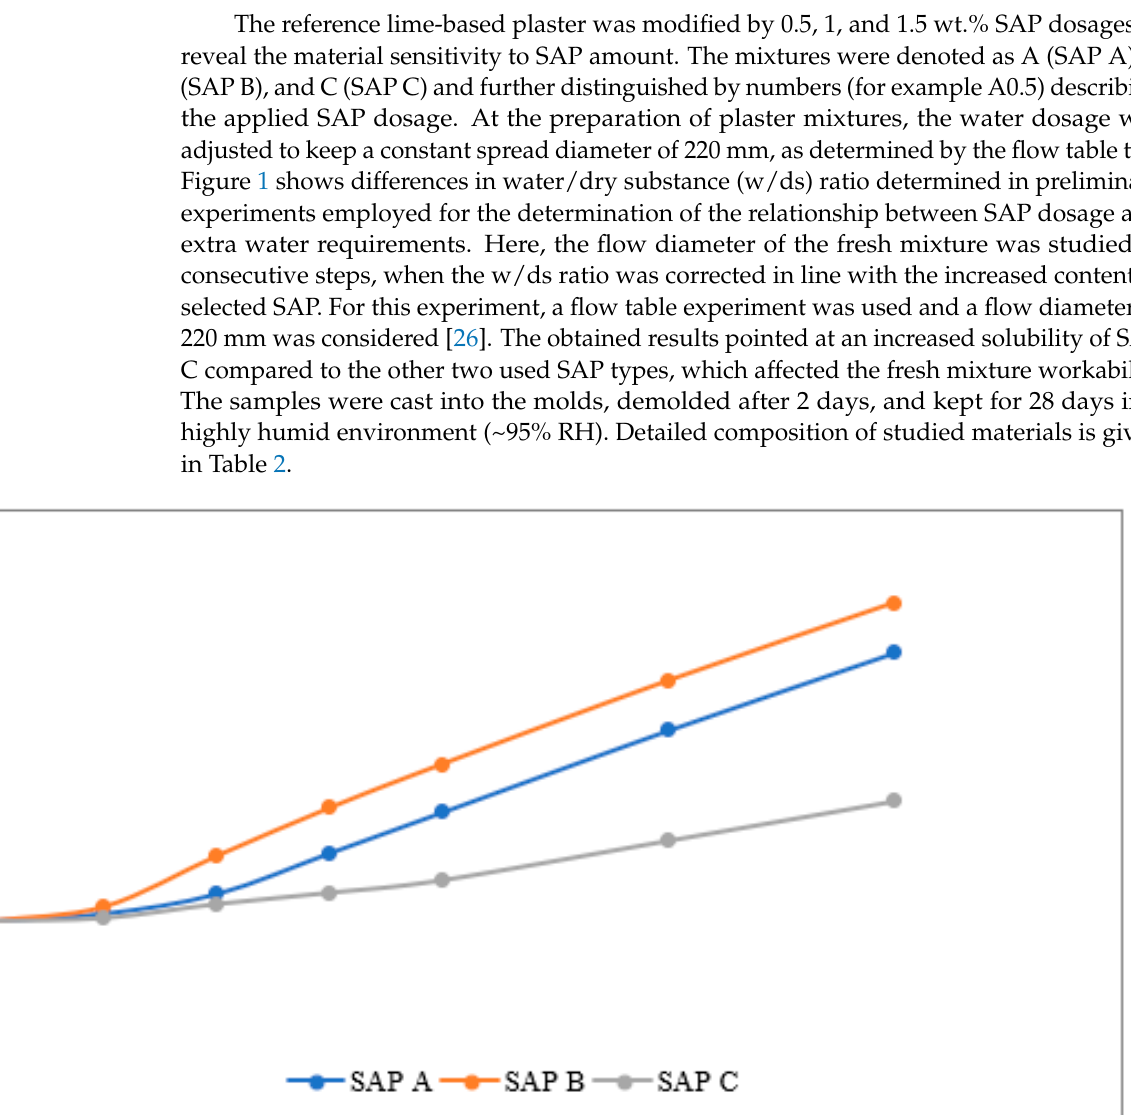
Table 1. Characteristics of used superabsorbent polymers.